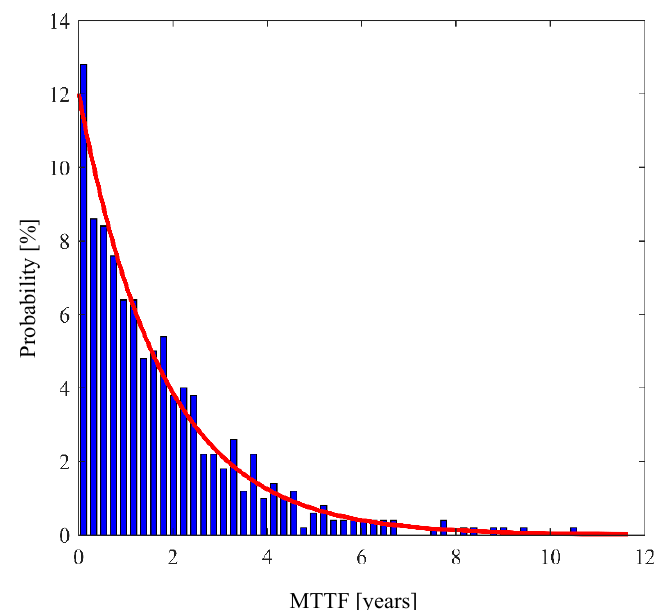
Figure 3. MTTF in the form of probability distribution for the application of the Monte Carlo approach.